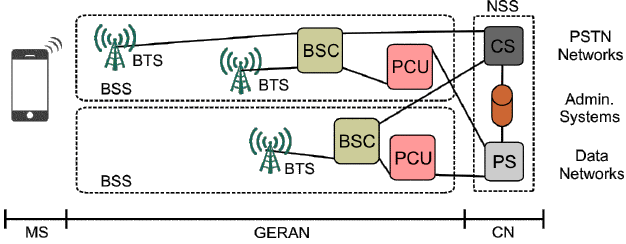
Figure A1. The architecture of GSM/GPRS/EDGE cellular